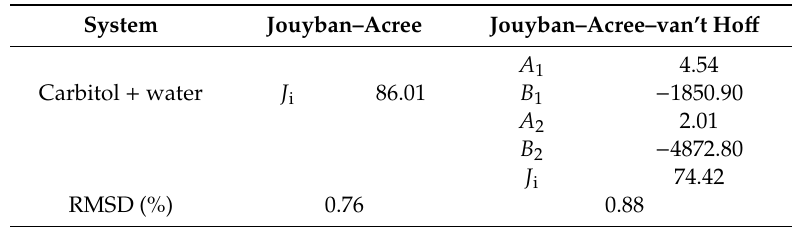
Table 8. The parameters of Jouyban–Acree and Jouyban–Acree–van’t Ho ff models for FFA in Carbitol + water